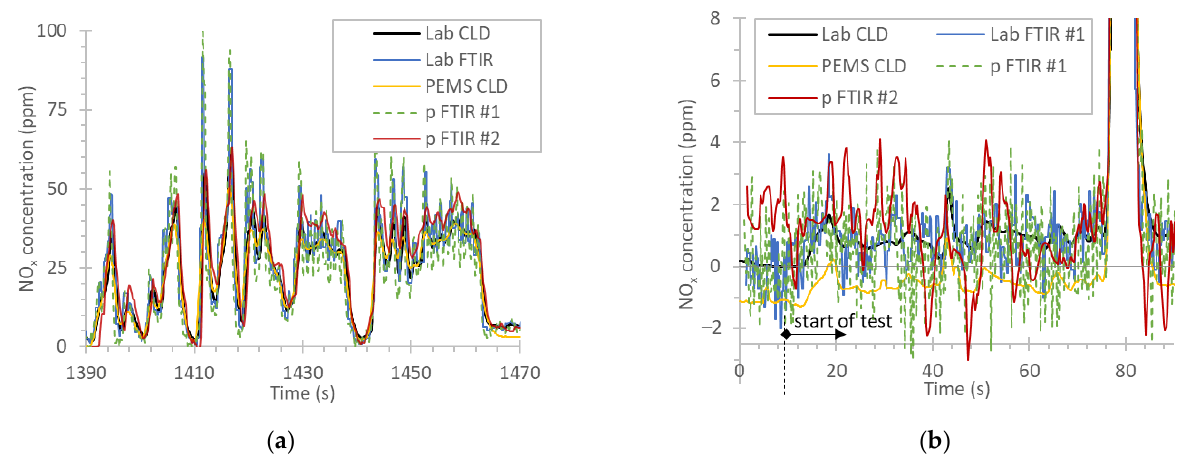
Figure 2. Real-time NO x concentrations of the diesel engine D1: ( a ) part of a typical WHTC; ( b ) first seconds of a WHTC. Reduced scale to focus on the zero levels of the instruments. CLD = chemilu- minescence detection; FTIR = Fourier transform infrared; p = portable; PEMS = portable emissions measurement system; WHTC = world harmonized transient cycle.